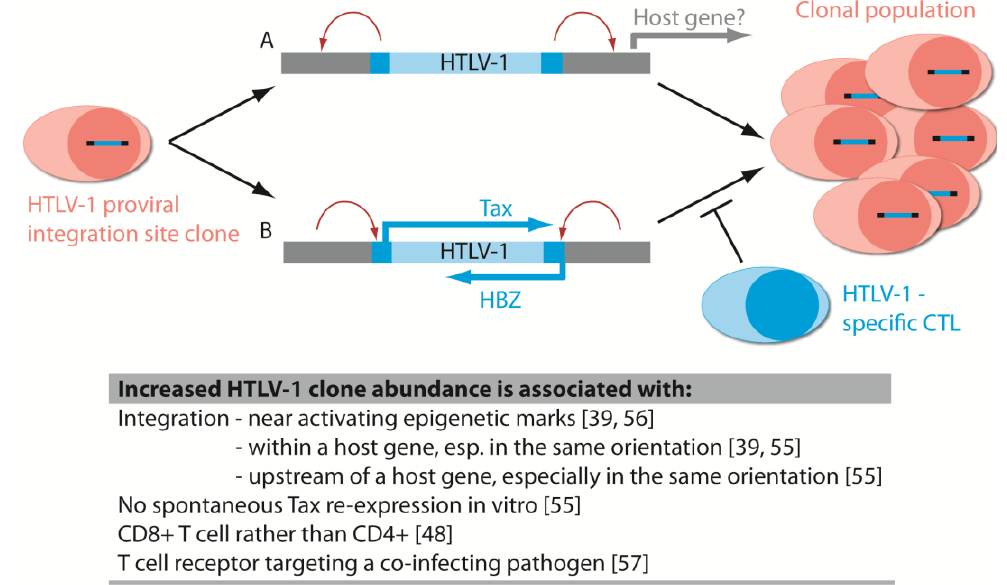
Figure 3. Expansion of HTLV-1 integration site clones in vivo . The abundance of HTLV-1 integration site clonal populations during chronic infection may be influenced by ( A ) alteration of host gene expression by viral LTRs and ( B ) features of the genomic environment that alter proviral expression of Tax and HBZ, which can both drive cell proliferation and expose the cell to the cytotoxic lymphocyte (CTL) response. Clone-specific factors not associated with genomic integration site but which may influence clone abundance include the specificity of the T cell antigen